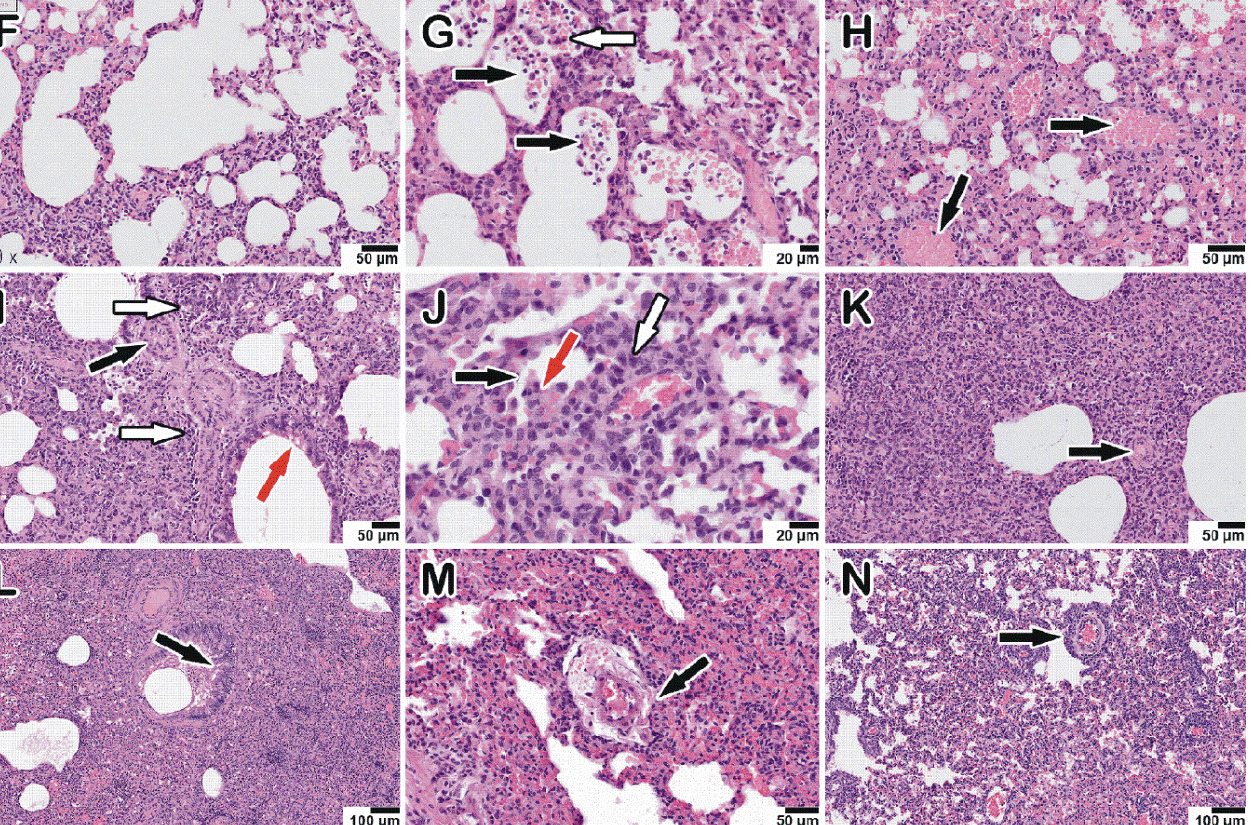
Figure 5. Histopathological alterations in hamster lungs monoinfected (HAdV-5, SARS-CoV-2, IAV) and coinfected with HAdV-5 and SARS-CoV-2. ( A ) mock-infected control animal, normal lung. ( B – E ) Representative images showing pathological changes in lung tissue after infection: ( B )—with HAdV-5; ( C )—with HAdV-5 and SARS-CoV-2 simultaneously; ( D )—with SARS-CoV-2; ( E )—with HAdV-5 and, 3 days later, with SARS-CoV-2. In both cases of coinfection with two viruses ( C , E ), there was a significant increase in the consolidation zones and pronounced perifocal compensatory atelectasis. ( F ) Manifestations of adenovirus infection: edema and mixed inflammatory cell infiltration of the interalveolar septa and, in the upper part of the image, pronounced plethora of the capillaries. ( G – K ) Typical pathological changes found in mixed infections. ( G ) Blood (black arrows), macrophages, and syncytium (white arrow) in the lumen of the alveoli and the activation and hyperplasia of type II pneumocytes. ( H ) Hemorrhage in the alveoli (black arrows). ( I ) Spasm of small vessels of the arterial type (black arrow); perivascular edema and perivascular lymphocytic infiltration (white arrow); desquamation of the epithelial lining of the bronchi (red arrow). ( J ) Destruction of the small bronchial wall (bronchiolitis, black arrow); desquamated bronchial epithelium in the lumen (red arrow); peribronchial and perivascular infiltration (white arrow). ( K ) Zone of consolidation of lung tissue with spasmodic arterioles (black arrow). ( L – N ) Manifestations of IAV infection: epithelial cell degeneration, vasculitis, and perivascular lymphocyte infiltration, respectively (black arrows). Staining with hematoxylin and eosin. All images were taken using a 40 × lens. The scale bar is shown in the